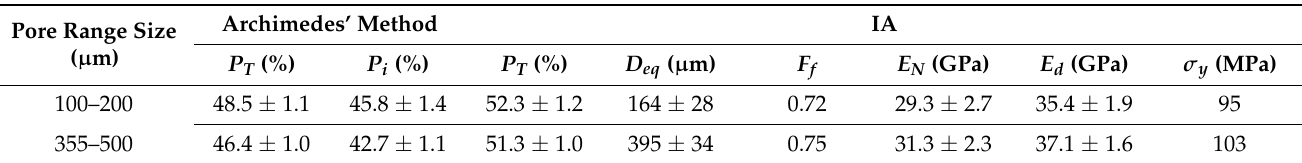
Table 1. Experimental parameters measured by Archimedes’ ( P T , P i ) and IA ( P T , D eq , F f ). Mechanical properties ( E N , E d , σ y ) estimated from IA data.